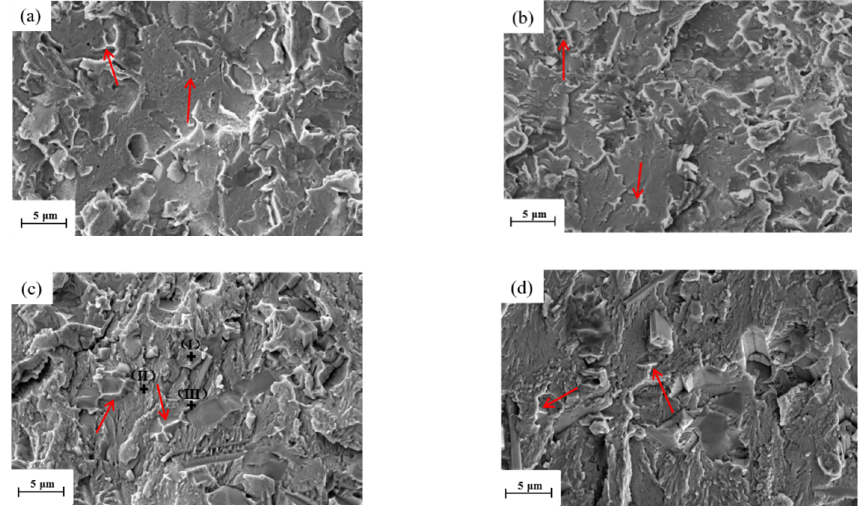
Figure 7. SEM fracture morphology: ( a ) 0°; ( b ) 20°, downward; ( c ) 30°, upward; ( d ) 50°, downward.